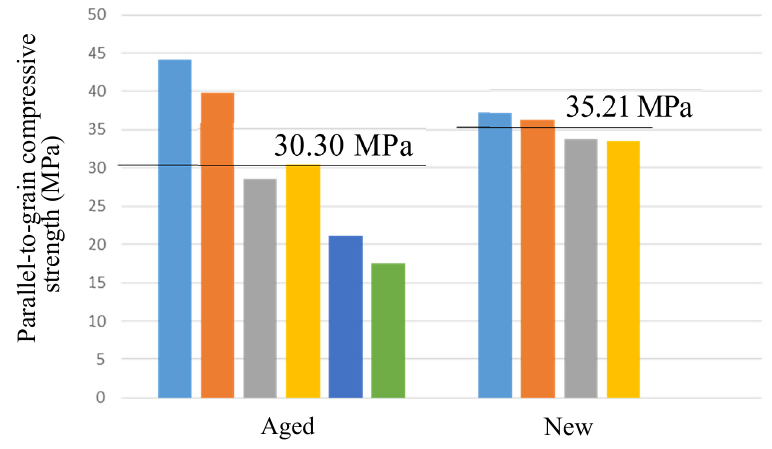
Figure 5. Parallel ‐ to ‐ grain compressive strength of aged and new logs. Figure 5. Parallel-to-grain compressive strength of aged and new logs.